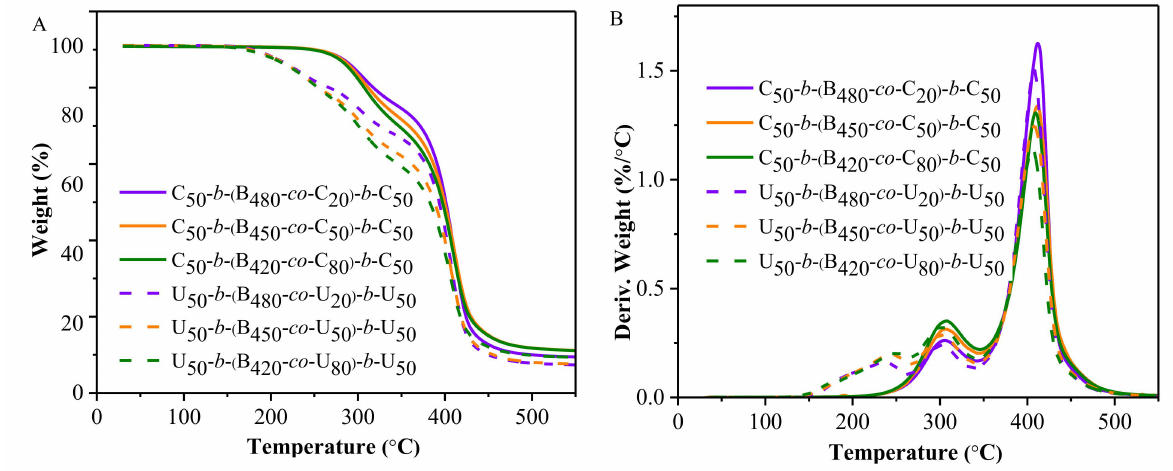
Figure 2. ( A ) TGA thermogram curves and ( B ) the corresponding weight derivative curves of CyA and UCyA triblock copolymers with varied amounts of hydrogen bonding